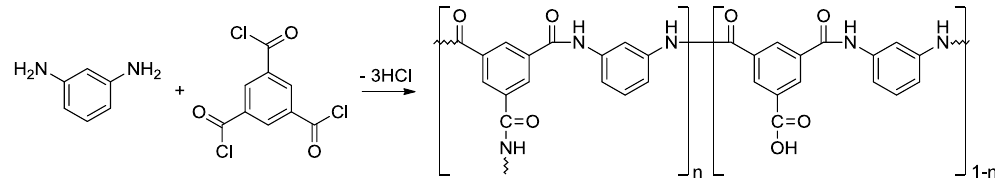
Figure 21. Interfacial polymerization between 1,3-phenylenediamine and trimesoyl chloride to produce a fully aromatic polyamide.